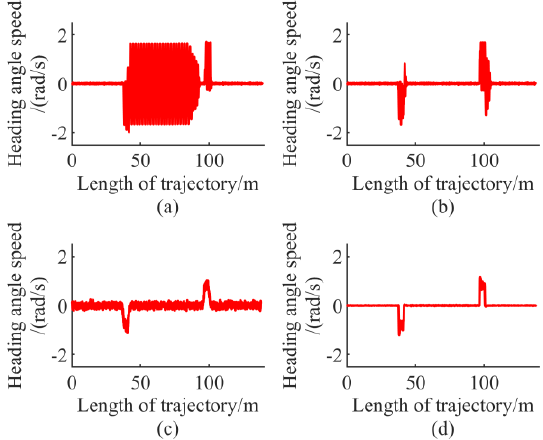
Electronics 2019 , 8 , x FOR PEER REVIEW Figure 40. The velocity of the final set of comparison. ( a ) LMPC. ( b ) LEMPC. ( c ) NMPC. ( d ) NEMPC. Figure 40. The velocity of the final set of comparison. ( a ) LMPC. ( b ) LEMPC. ( c ) NMPC. ( d ) NEMPC. Figure 40. The velocity of the final set of comparison. ( a ) LMPC. ( b ) LEMPC. ( c ) NMPC. ( d ) NEMPC.